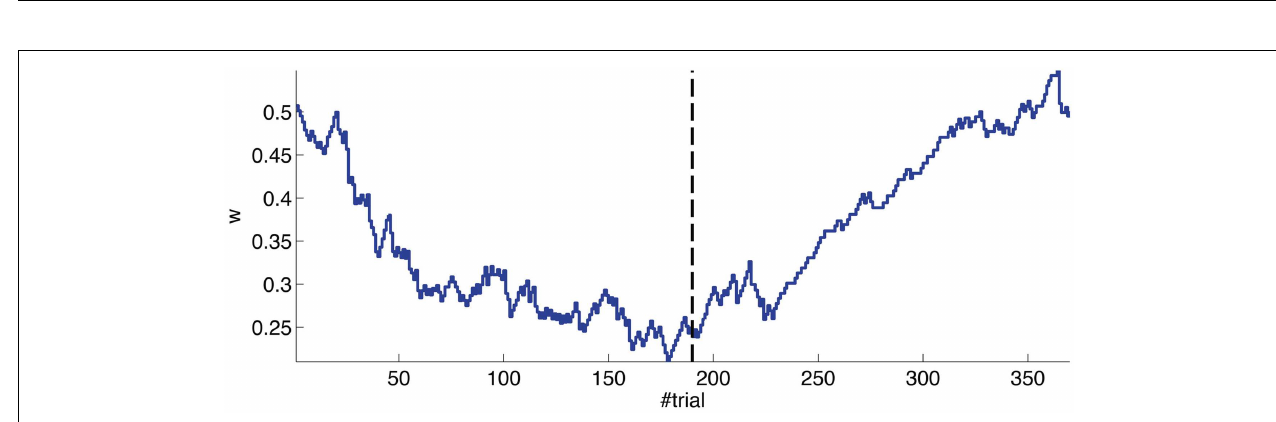
FIGURE 12 | Quantitative results. (A) Events detected in the PN. Histogram of PN detections relative to the CS-trigger:TDs (black bars) and FAs (gray bars); in this case all FAs are late CS-detections. CS period (yellow area) and US period (pink area). (B) Events detected in the IO. Detections in the IO sorted relative to the US-trigger. Data plotted as in (A) . (C) Behavioral performance of the bio-hybrid. Percentage of well-timed CRs